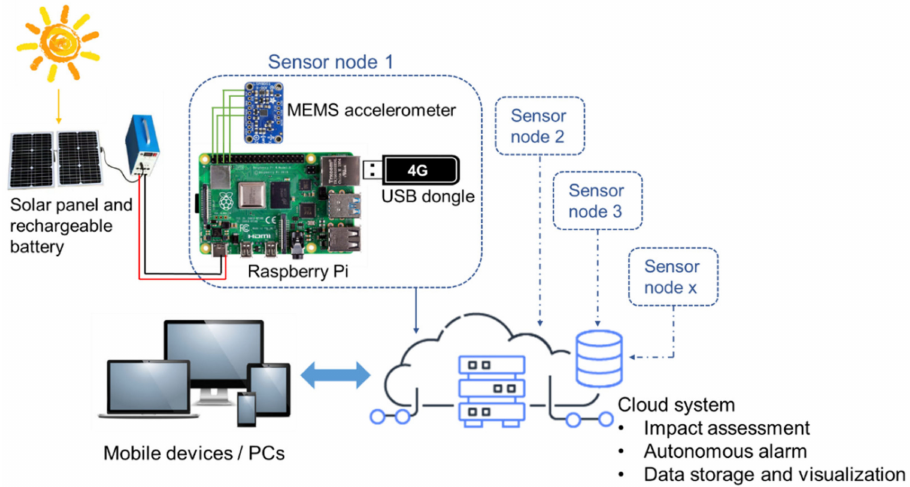
Figure 2. The structure of the Internet of Things (IoT) sensing system for construction vibration